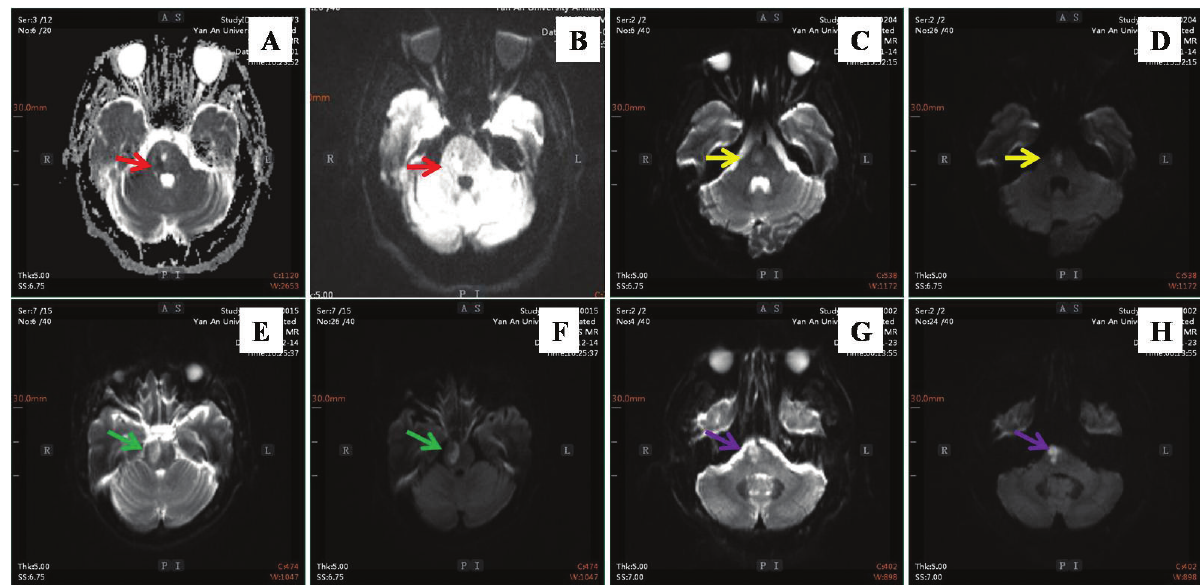
Figure 1: Magnetic Resonance Imaging (MRI) of patients with acute cerebral stroke and dysphagia (A & B: 66 year old male patient with brainstem infarction; C & D: 74 year old female patient with brainstem infarction; E & F: 71 year old female patient with brainstem infarction; G & H: acute brainstem infarction of a 68 years old male patient). The MRI-recording modalities were A: apparent diffusion coefficients (ADC); B: fluid attenuated inversion recovery (FLAIR); C, E, G: T2 weighted image (T2WI); D, F, H: diffusion weighted image, (DWI).